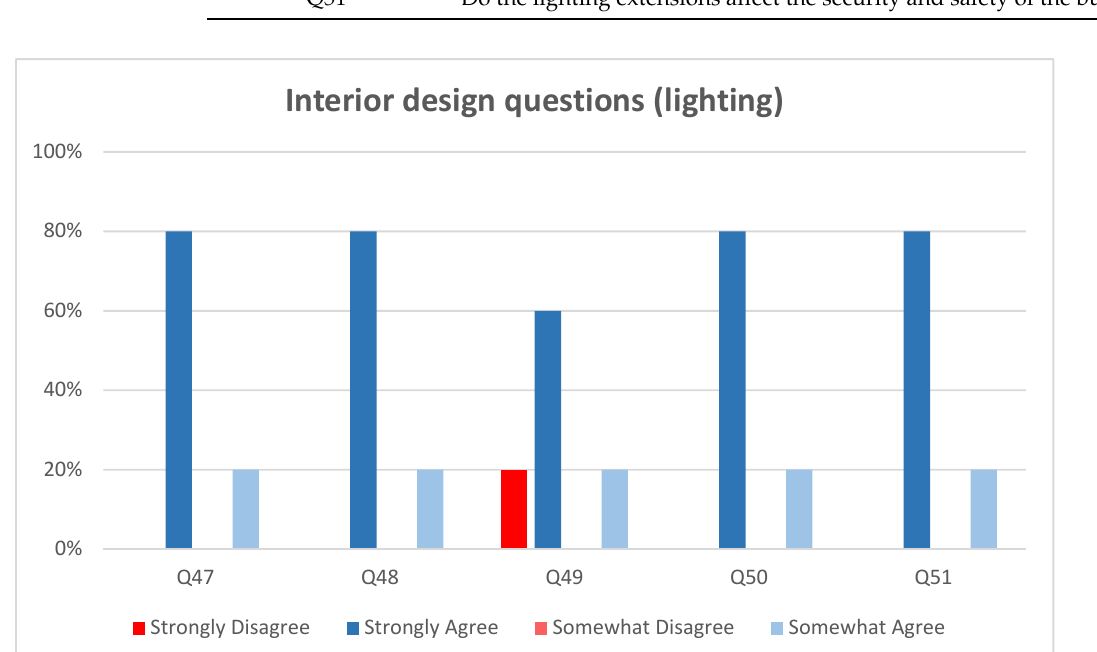
Figure 13. Results for the questions on lighting.